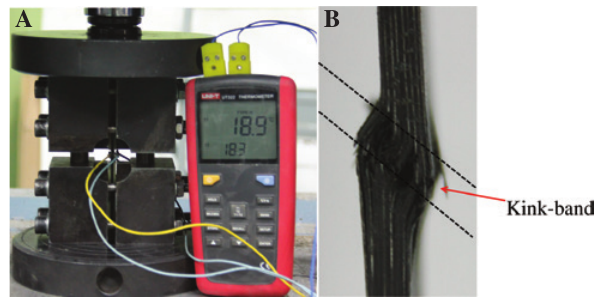
Figure 2: The macroscopic loading conditions of the specimens under longitudinal compression. (A) Before the test; (B) after the